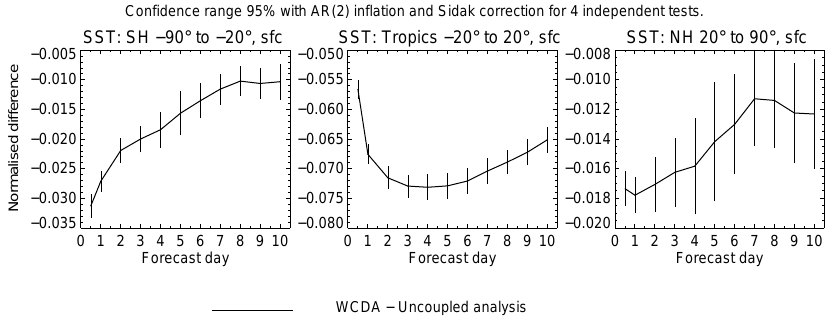
Figure A2. As Figure A1 but for sea-surface temperature. Figure A2. As in Figure A1 but for sea-surface temperature.